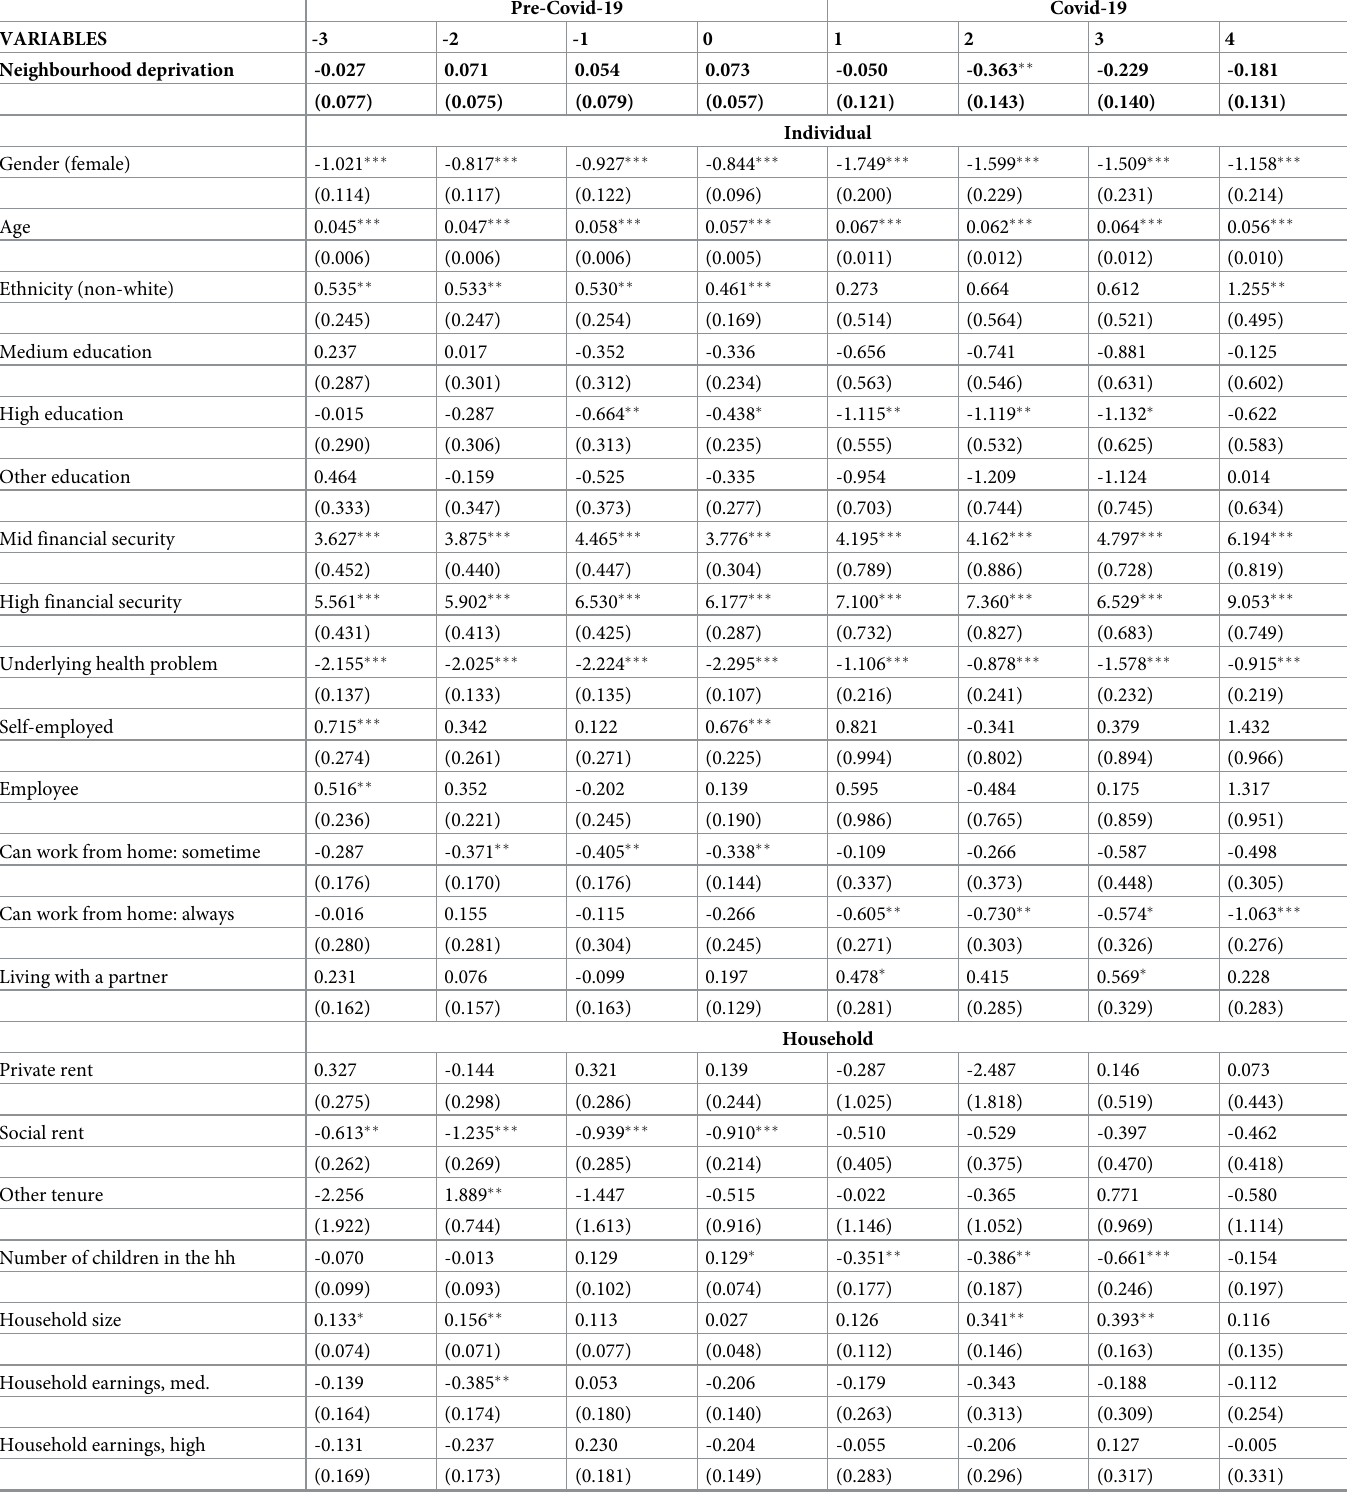
Table 2. Hedonic Well-being, full model OLS cross-section by